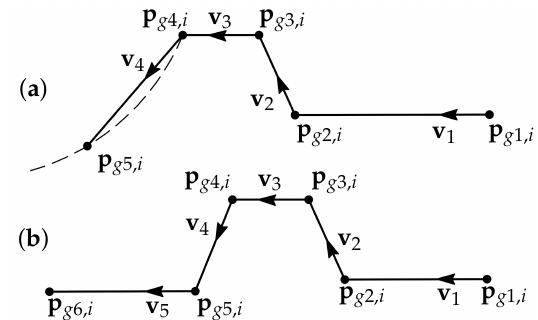
Figure 6. Two models for groove profiles: ( a ) a T-joint (i.e., stub joint) groove and ( b ) a butt joint groove (a V-groove) with a root weld. A stub groove and a butt groove consist of five or six corner points, respectively, which can also be represented as four or five sequentially connected line segments. The vectors v i show the directions of the